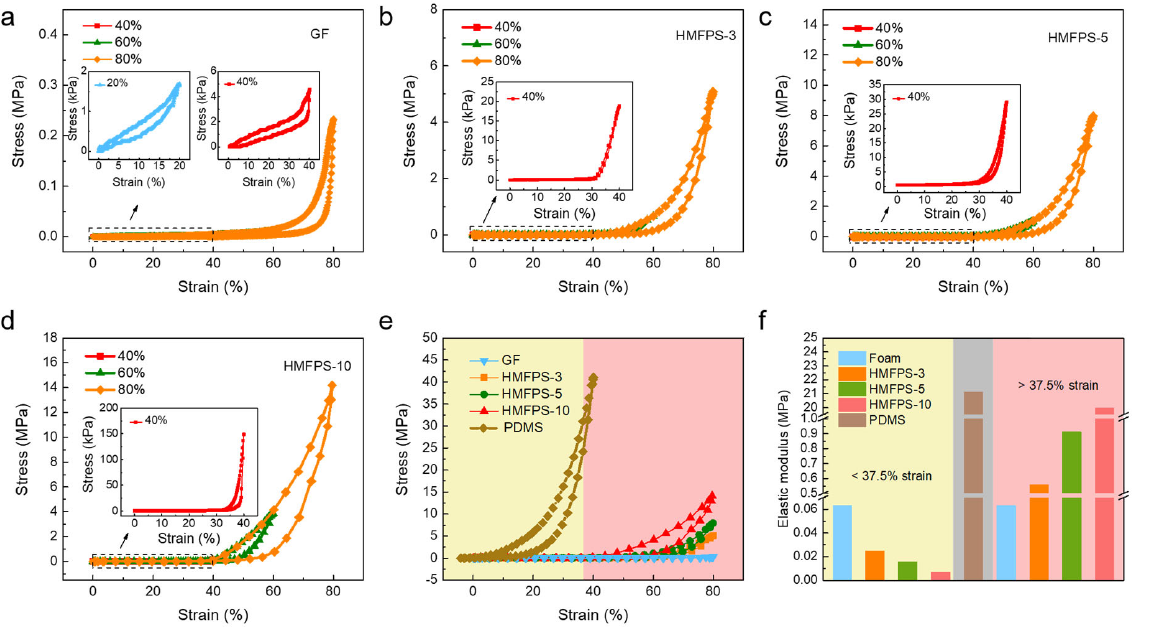
Figure 4. Compressive stress–strain curves of ( a ) GF, ( b ) HMFPS-3, ( c ) HMFPS-5, and ( d ) HMFPS- 10 under 40%, 60%, and 80% strain; ( e ) Compressive stress–strain curves, and ( f ) elastic modulus of Gf, HMFPS-3, HMFPS-5, HMFPS-10, and PDMS bulk.